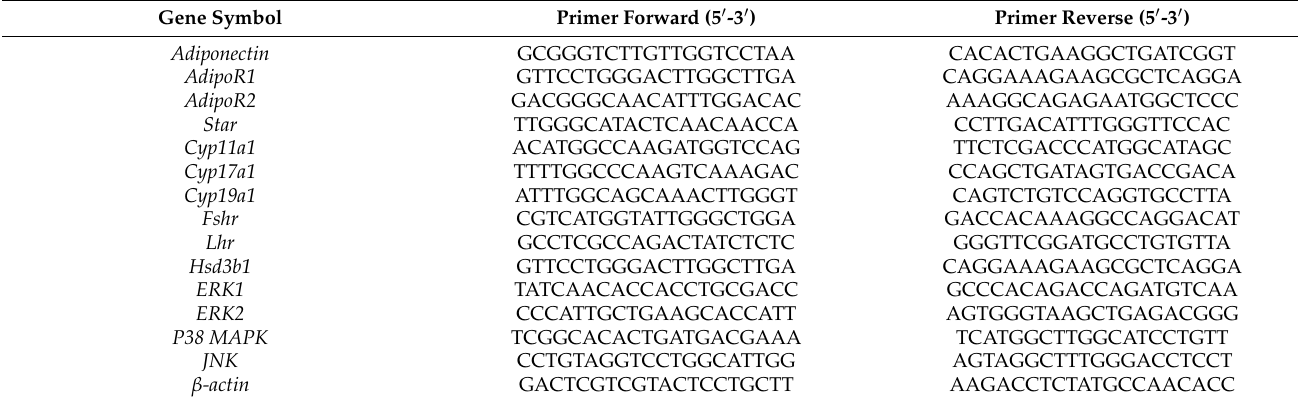
Table 4. Oligonucleotide sequences for real-time quantitative PCR. Gene Symbol Primer Forward (5 (cid:48) -3 (cid:48) ) Primer Reverse (5 (cid:48) -3 (cid:48)